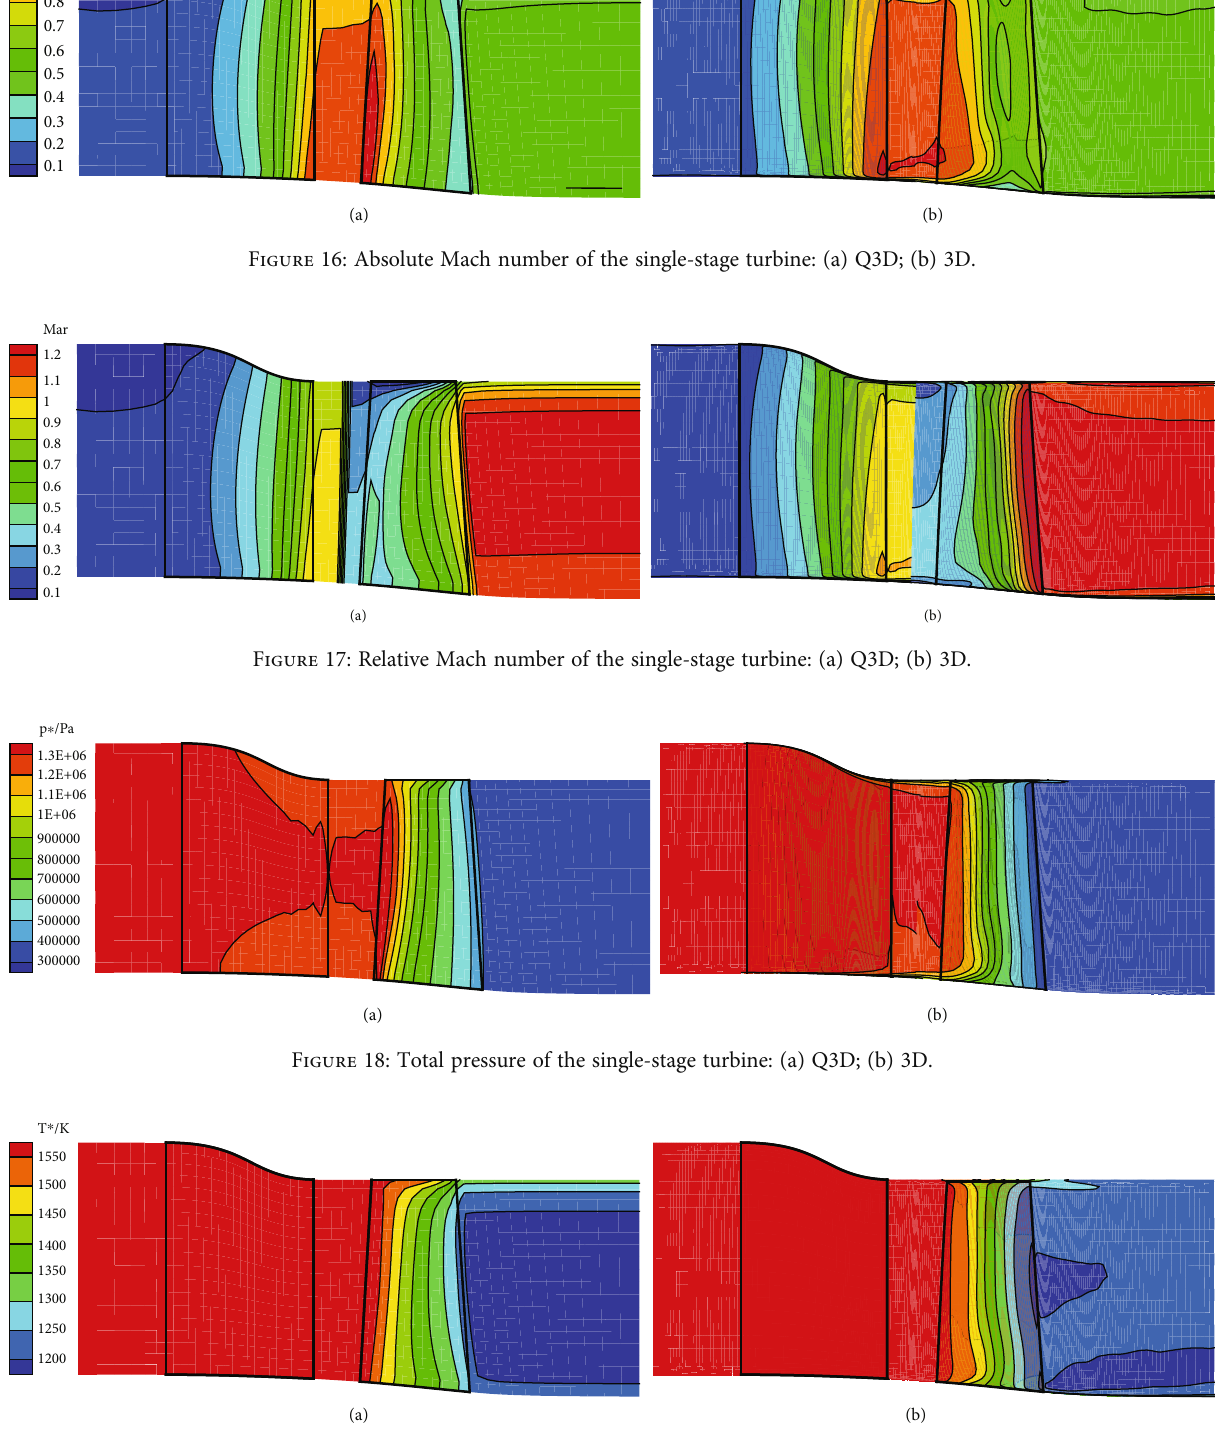
Figure 19: Total temperature of the single-stage turbine: (a) Q3D; (b)